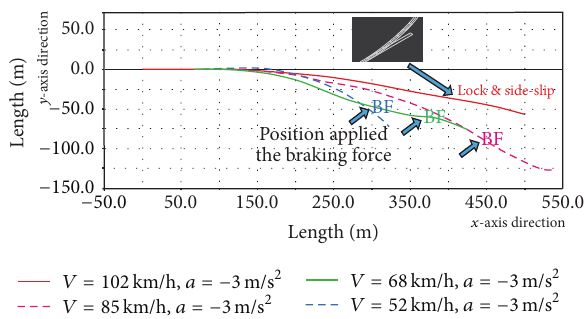
Figure 8: Vehicle trajectory with a braking deceleration of 3m/s 2